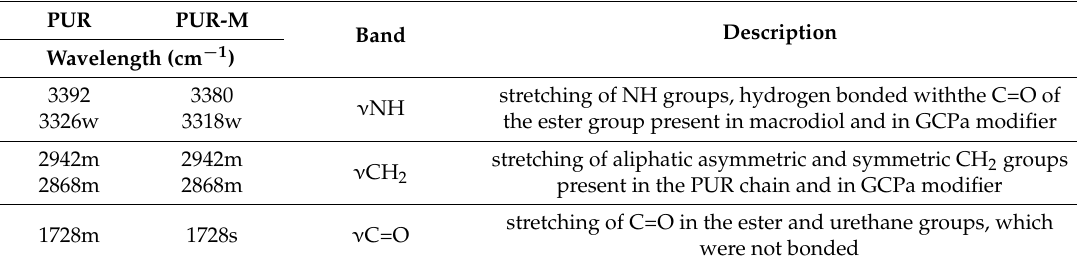
Table 2. Spectral data and band assignments of FTIR analysis presented in Figure 2.